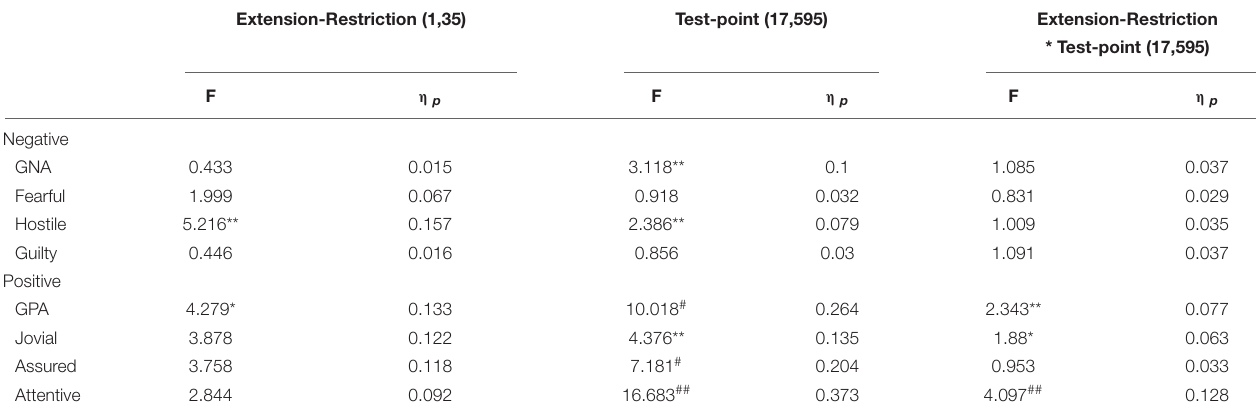
TABLE 3 | Effects of sleep history (extension-restriction) and accumulating sleep loss (test point during sleep deprivation) on Negative and Positive moods.